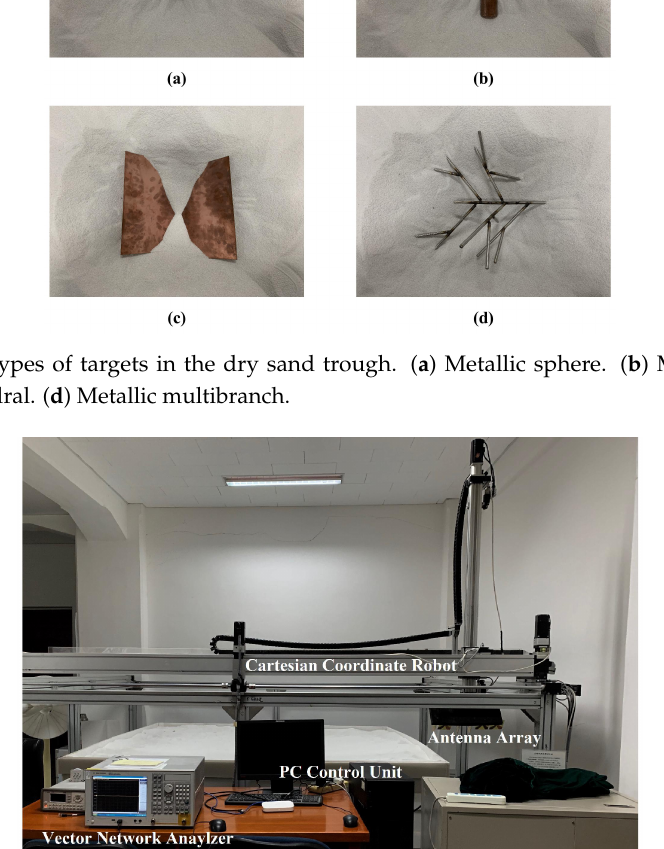
Figure 5. Full polarimetric ground penetrating radar (GPR) measurement system.